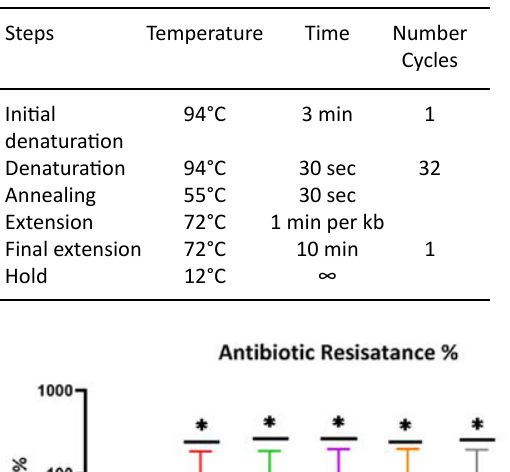
Table 2. PCR programme used for genes screen